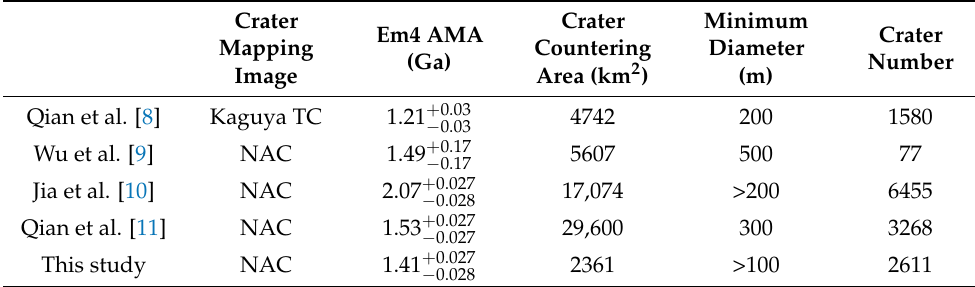
Table 2. Absolute model age dating results of Em4 in this study and previous studies.